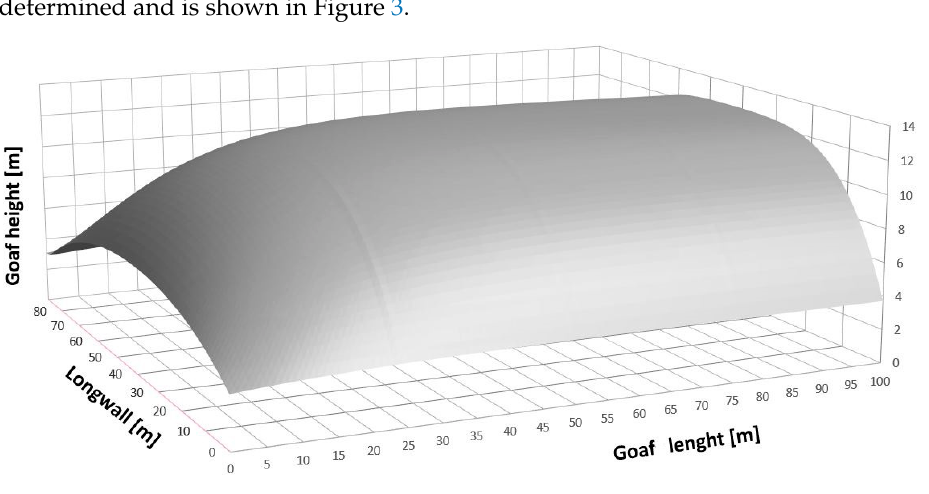
Figure 2. Geometry of numerical model.